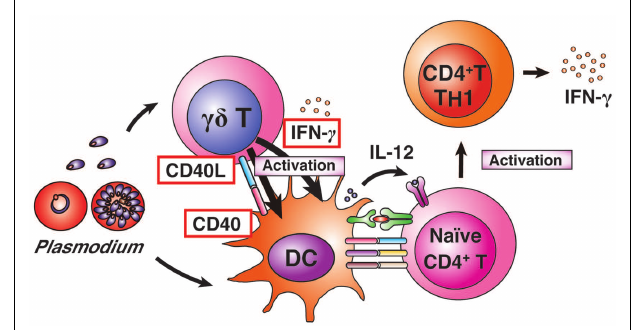
FIGURE 3 | γδ T-cell-related protective immunity . γδ T cells and DCs are activated by Plasmodium infection. Activated γδ T cells begin to express CD40L and produce IFN- γ .The activated γδ T cells enhance MHC II and co-stimulatory factors on DCs, and induce high levels of IL-12 production from DCs.The CD40L-expressing γδ T cells enhance DC activation. Activated DCs induce differentiation of naïve CD4 + T cells into IFN- γ -producingT H 1